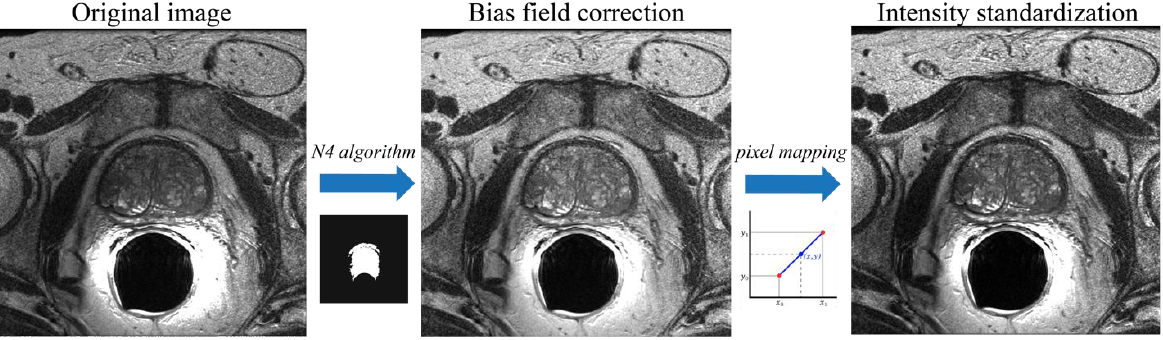
Figure 2. Pre-processing steps applied to each MRI volume. First, the N4 algorithm is used for bias field correction. Then, intensity normalization is applied to standardize each MRI volume.